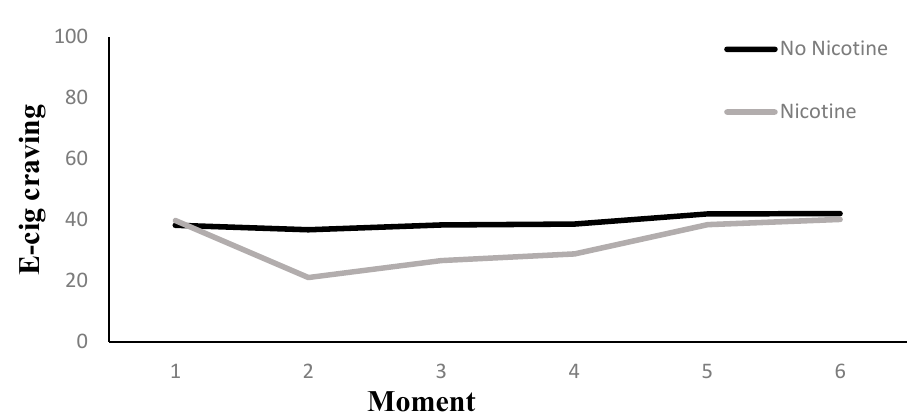
Figure 9. The interaction between moment and nicotine level in the Unipod condition for e-cig craving.